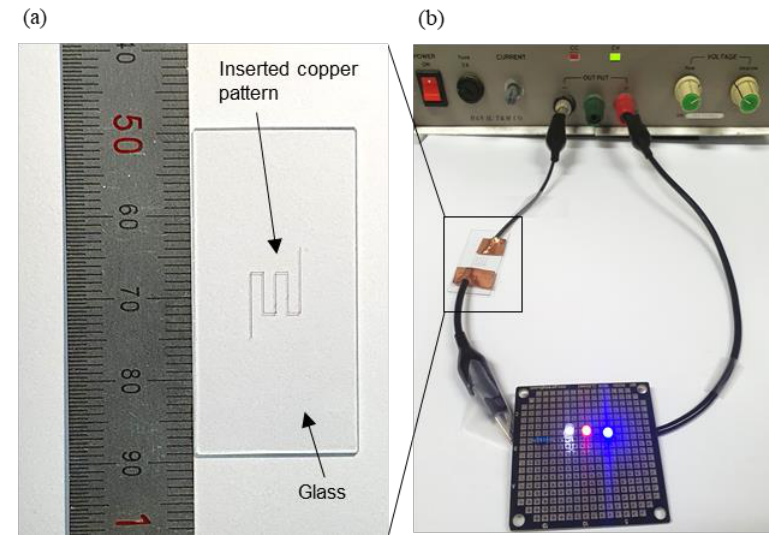
Figure 14. Conductivity test of embedded copper wire. ( a ) Shape of the embedded copper pattern. ( b ) Simple LED circuit.